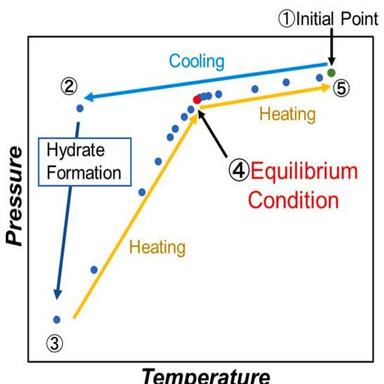
Outline of the experiment for the batch isochoric procedure.